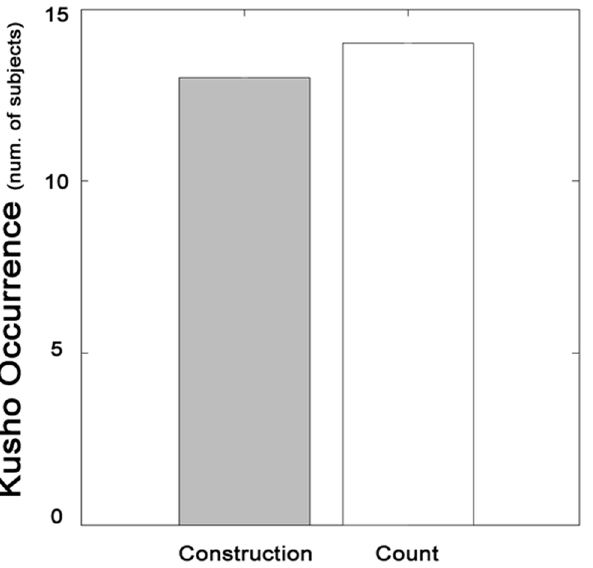
Fig 2. Kusho occurrence in the construction task and the stroke count task. In both tasks, kusho behavior appeared in almost all participants with no difference in the occurrence of kusho behavior between two